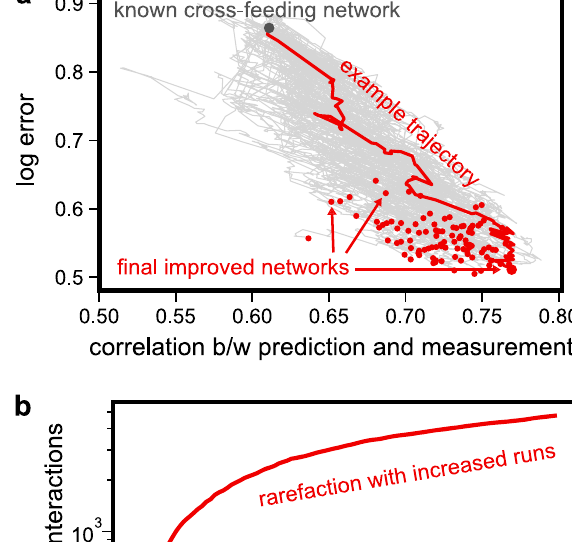
Table 1 Cross-validating the newly predicted interactions.